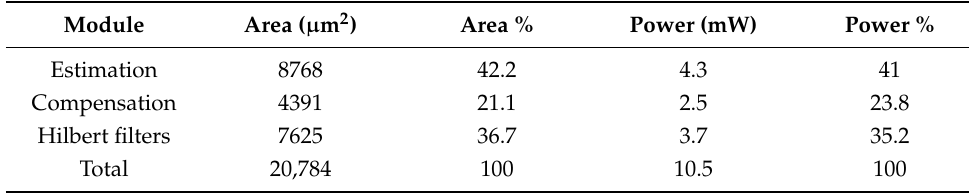
Table 1. The synthesized results of power and area.